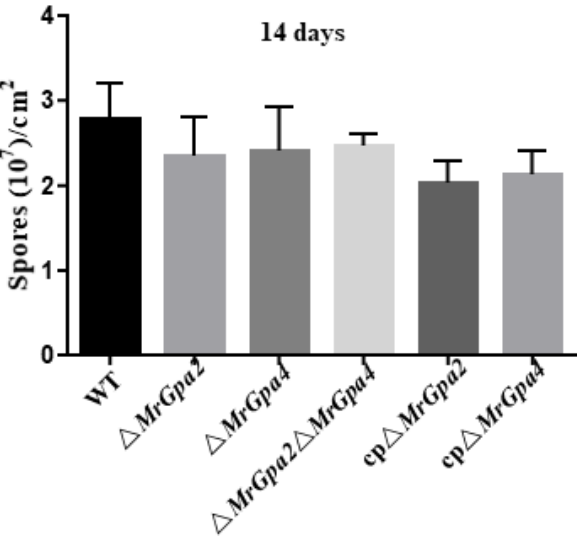
Figure 5. The conidial yield of six strains on PDA plates at 25 °C for 14 days.